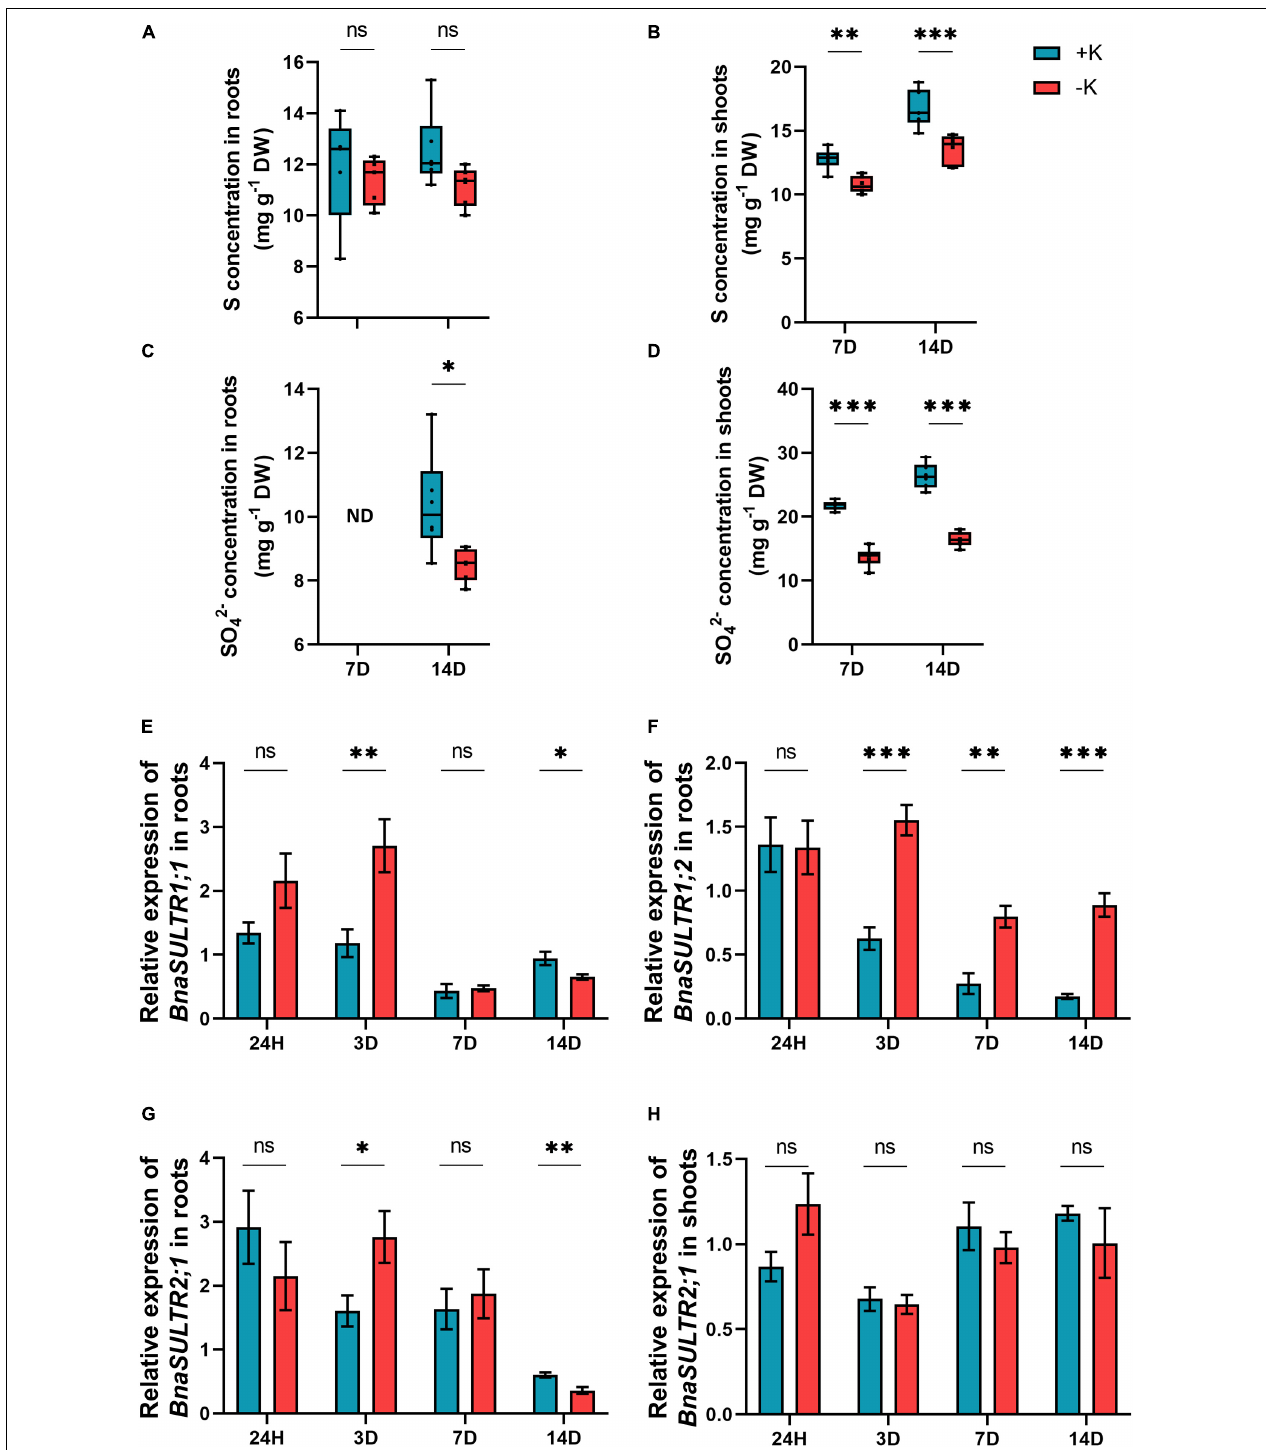
FIGURE 5 | Influence of K deficiency on S status and the genes involved in S transport in rapeseed plants. (A) S concentration in roots; (B) S concentration in shoots; (C) SO 42 − concentration in roots; (D) SO 42 − concentration in shoots; (E) relative expression of BnaSULTR1;1 in roots; (F) relative expression of BnaSULTR1;2 in roots; (G) relative expression of BnaSULTR2;1 in roots and (H) relative expression of BnaSULTR2;1 in shoots. Plants were grown in a hydroponic culture under either –K (0 mM) or + K (2 mM). Roots and shoots were harvested after 24 h, 3, 7, or 14 days of K deprivation. Bars indicate mean ± standard error of the mean (SEM) ( n = 6). Asterisks denote the significant level of the difference according to t -test ( ∗ p < 0.05, ∗∗ p < 0.01, and ∗∗∗ p < 0.001, n = 6). Ns denotes non-significant differences.